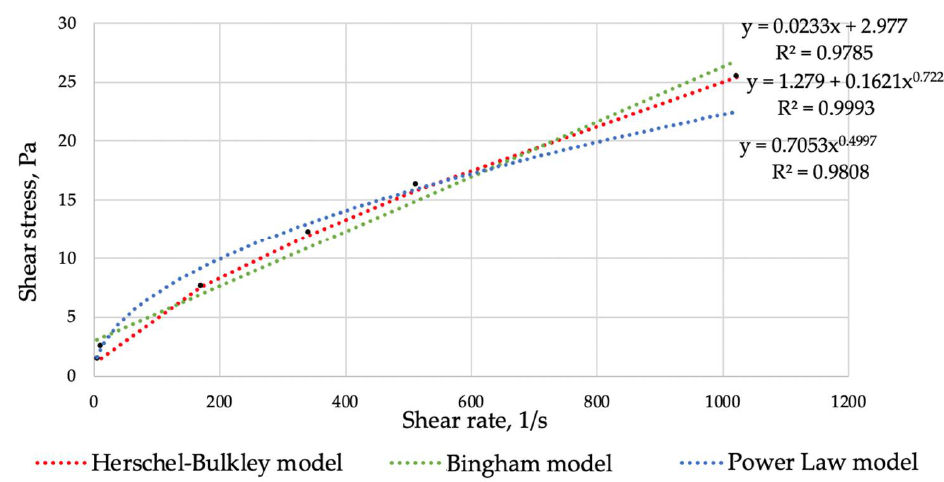
Fluids 2021 , 6 , x FOR PEER REVIEW Figure 3. Selection of the rheological model for basic mud 1. Figure 3. Selection of the rheological model for basic mud 1.